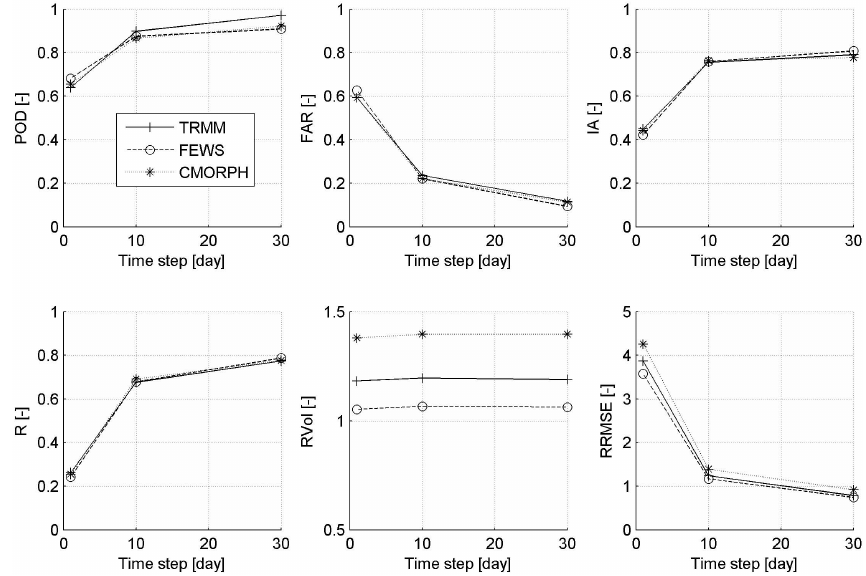
Fig. 6. Statistics for the ARA-Zambeze gauges. Data analyzed from January 2003 to December 2009. POD: probability of detection, FAR: false alarm ratio, R : correlation coefficient, RVol: volume ratio, RRMSE: relative root mean square error.